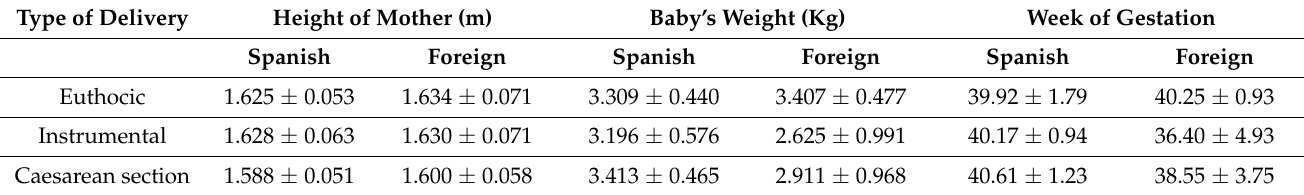
Table 5. Relationship between maternal height, birth weight and weeks of